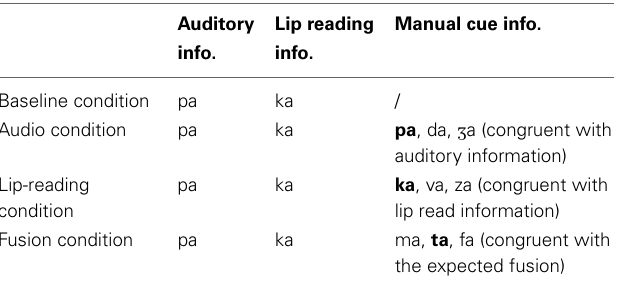
Table 3 | The composition of McGurk stimuli in incongruent conditions.